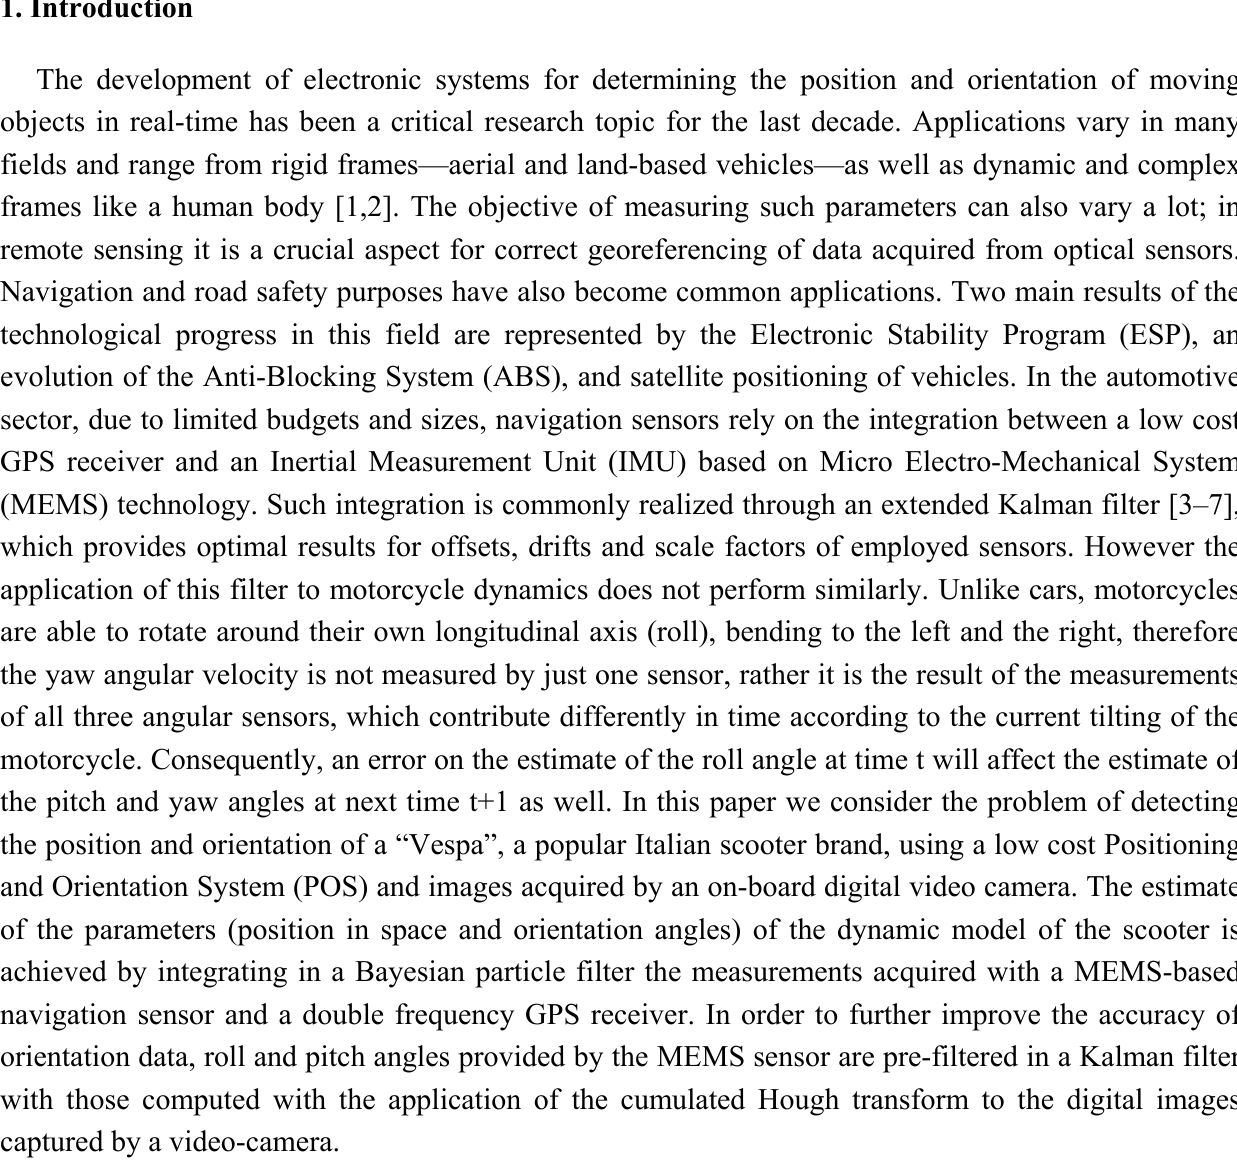
Figure 1. The system consists of an XSens MTi-G MEMS-based Inertial Measurement Unit (IMU) and a 1.3 Megapixel SONY Progressive Scan color CCD camera. The main technical specifications of